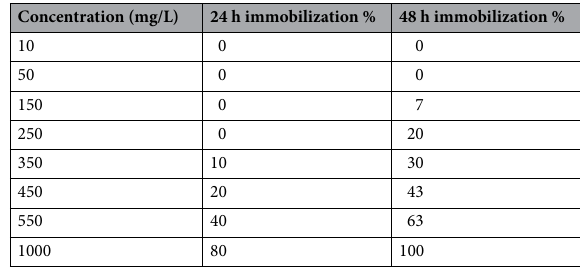
Table 3. Artemia salina mean immobilization % after 24 and 48 h of exposure to different concentrations of PANI/Ag (AMPSA)/GO QDs NC.